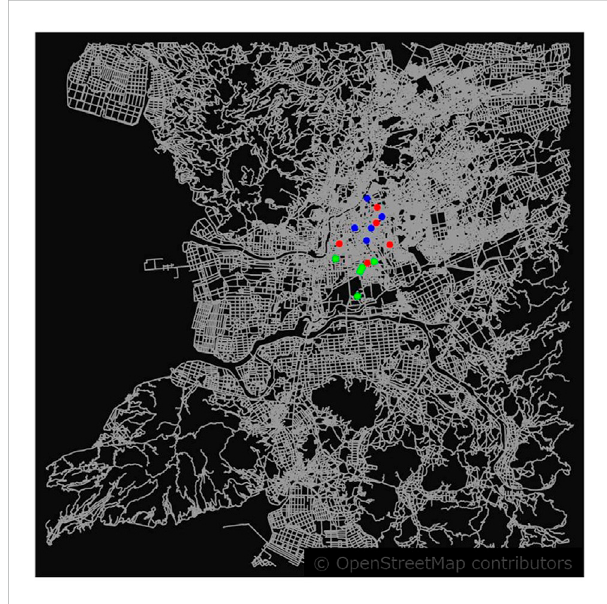
FIGURE 3 Location of the three clusters in instance No. 1 of the base